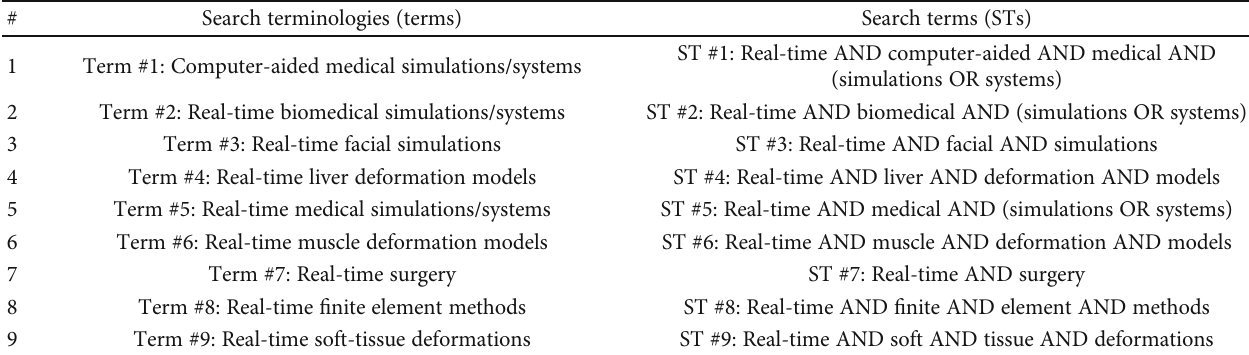
Table 1: The search terms used for the systematic review